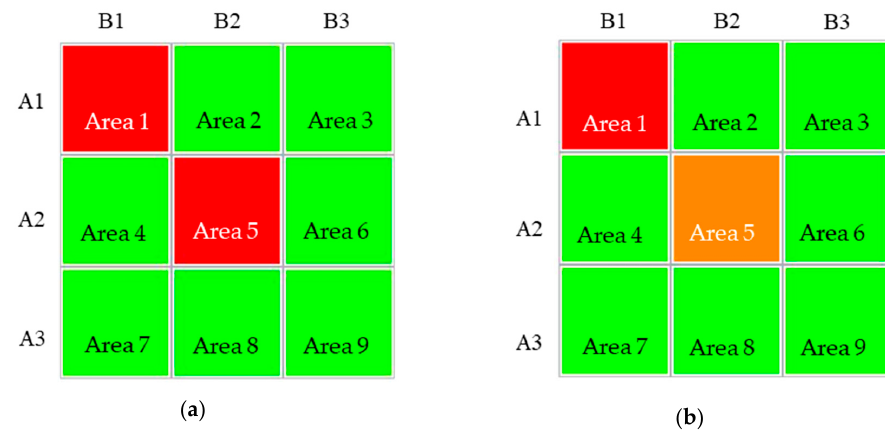
Figure 13. Warning areas judgment logic. ( a ) First Step; ( b ) Second Step.